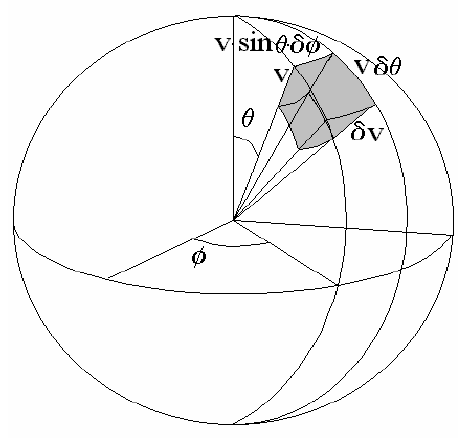
Figure 122: Unit volume in phase